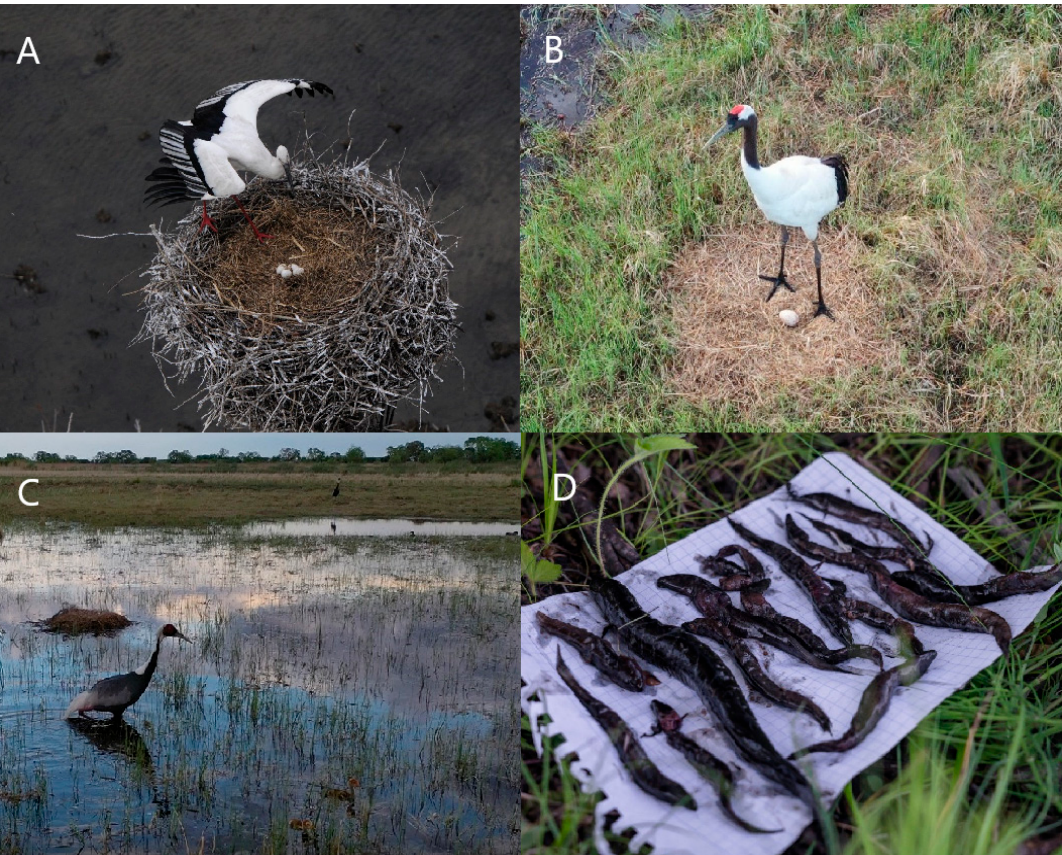
Figure 2. The endangered bird species inhabiting wetlands under the impact of dams, and their food supply. ( A ) Oriental stork ( Ciconia boyciana ), by D. Korobov; ( B ) Red-crowned crane ( Grus japonensis ), by A. Sasin; ( C ) White-naped crane ( Grus vipio ), by A. Sasin; ( D ) Loaches ( Misgurnus mohoity ) and